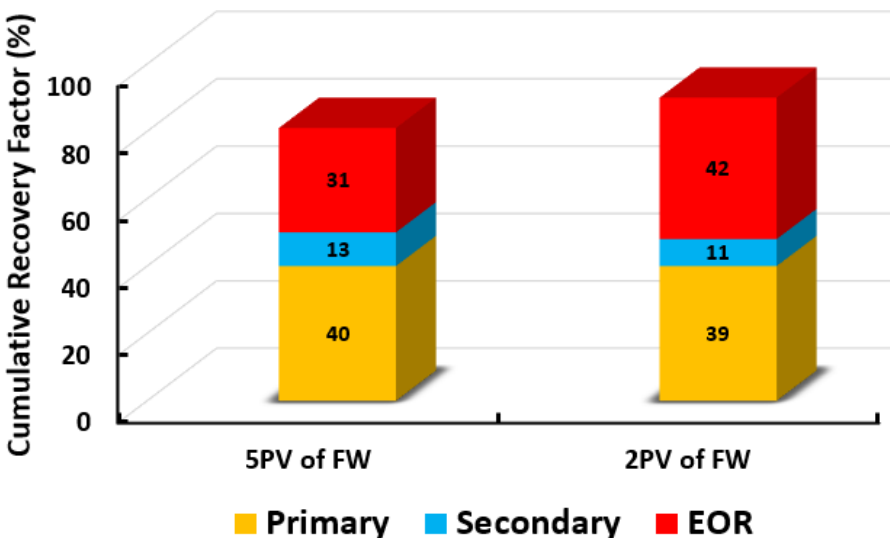
Figure 36. The effect of slug size of smart water injection (MgCl 2 + oil Type A); The case of SWAF injection scenario with 2 PVs leads to more EOR recovery compare 5 PVs. Besides, it has less fluid circulation costs and thus has a lower CO 2